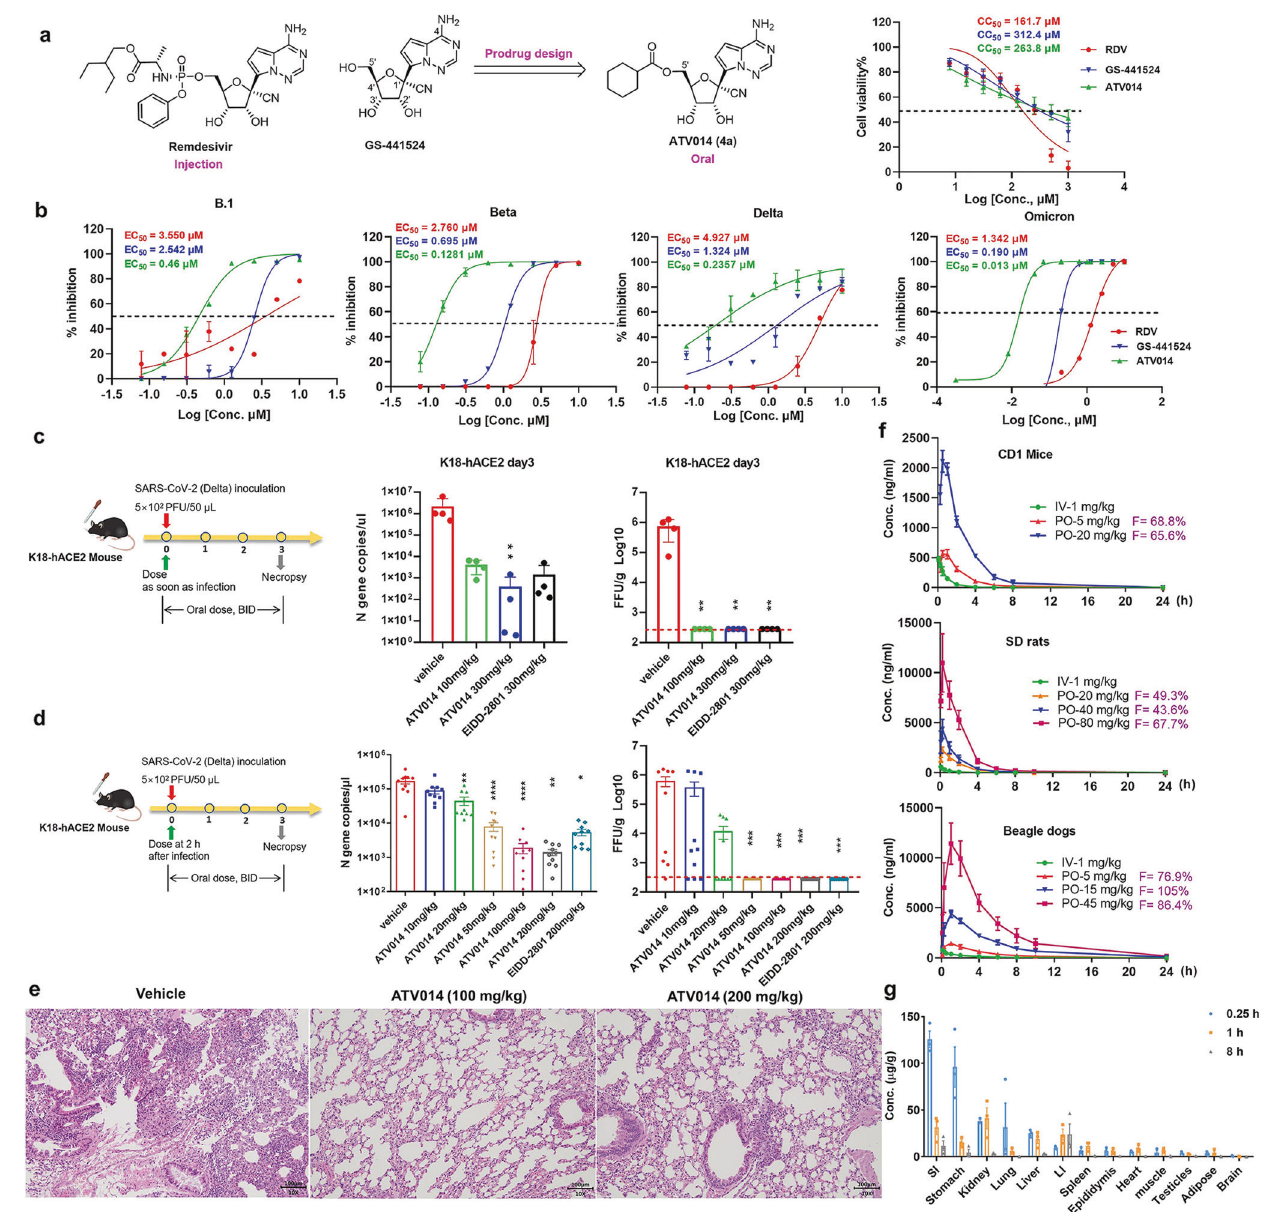
Fig. 1 De fi nition of a potential orally anti-SARS-CoV-2 drug ATV014 and its preclinical characterization. a The chemical structures of remdesivir, GS-441524 and ATV014. b Antiviral activity of RDV, GS-441524, and ATV014 against B.1, Beta, Delta, and Omicron strains of SARS- CoV-2 and corresponding cytotoxicity in Vero E6 cells. c Schematic of the prophylactic ef fi cacy in a K18-hACE2 mice model. K18-hACE2 mice were intranasally inoculated with SARS-CoV-2 Delta variant (5 × 10 2 PFU virus per mouse) and were immediately oral treated with vehicle, ATV014 (100, 300 mg/kg) or EIDD-2801 (300 mg/kg), before the inoculation and continued for three days (bis in die (BID), n = 4 per group). Following results demonstrated the abundance of SARS-CoV-2 N gene copies in mouse lungs via qRT-PCR (quantitative real-time polymerase chain reaction) and virus viability via FFA (focus forming assay) at 3 dpi. The detection limit of qRT-PCR was 0.5 copies/ μ L. The red dashed line indicates the limit of detection for the FFA. d Flowsheet of the therapeutic ef fi cacy. K18-hACE2 mice were intranasally inoculated with the SARS-CoV-2 Delta variant (5 × 10 2 PFU per mouse) and were treated with vehicle, ATV014 (10, 20, 50, 100 or 200 mg/kg), or EIDD-2801 (200 mg/kg) at two hours after SARS-CoV-2 infection ( n = 10 per group). Following results showed the abundance of SARS-CoV-2 N gene copies in mouse lungs via qRT-PCR and virus viability via FFA at 3 dpi. e Representative H&E images of lung sections of the lungs of the vehicle-treated, 100 mg/kg ATV014-treated and 200 mg/kg ATV014-treated mice. f Mean plasma concentrations of ATV014 following single intravenous (1.0 mg/kg) and oral (5 and 20 mg/kg) administration of ATV014 in CD1 mice ( n = 3 per group). single intravenous (1.0 mg/kg) and oral (20, 40 and 80 mg/kg) administration of ATV014 in SD rats ( n = 6 per group) and single intravenous (1 mg/kg) and oral (5, 15, and 45 mg/ kg) administration in beagle dogs ( n = 6 per group). g Tissue distribution of the key metabolite GS-441524 in male rats after a single oral administration of ATV014 at 80 mg/kg. SI: small intestine; LI: large intestine. Error bars indicate SEM. A Kruskal – Wallis test was used for statistical analysis. ∗ P ≤ 0.05; ∗∗ P ≤ 0.005; ∗∗∗ P ≤ 0.0005; ∗∗∗∗ P ≤ 0.0001